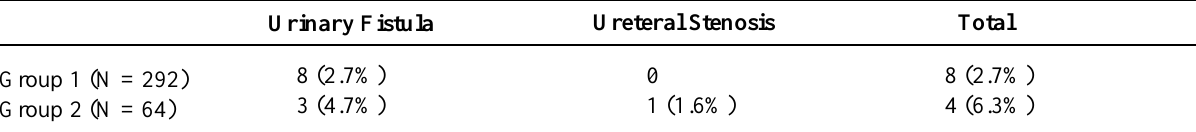
Table 5 – Urological complications among single (group 1) and multiple (group 2) arteries grafts.